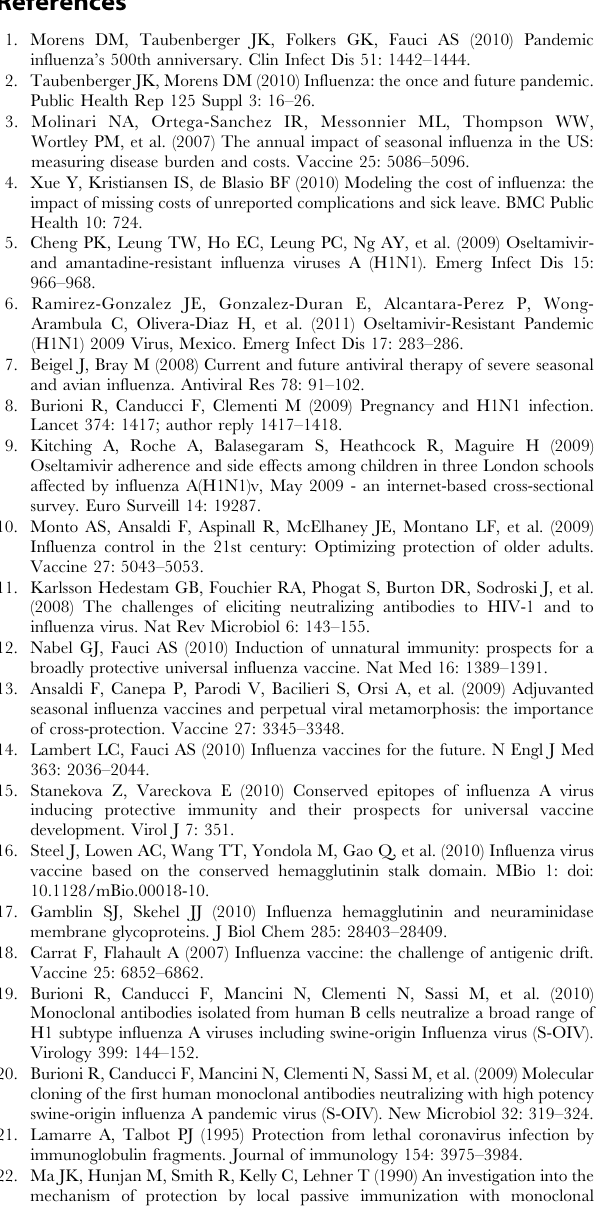
H3N2 viruses neutralized by PN-SIA28. Data from two different experiments for each strain are reported. Each point was performed in triplicate. Figure S3 Unrooted tree of HA1 region of H3 hemag- glutinins. The different isolates belong to different historical periods spanning 1968 to 2009. The three different clusters characterizing the H3N2 pandemic are evidenced, with each cluster including isolates belonging to a distinct time period of the pandemic. Green ‘ + ’ or red ‘ 2 ’ indicate PN-SIA28 positive and negative neutralizing activity, respectively. Table S1 HA amino acidic residues mutated in H1 and